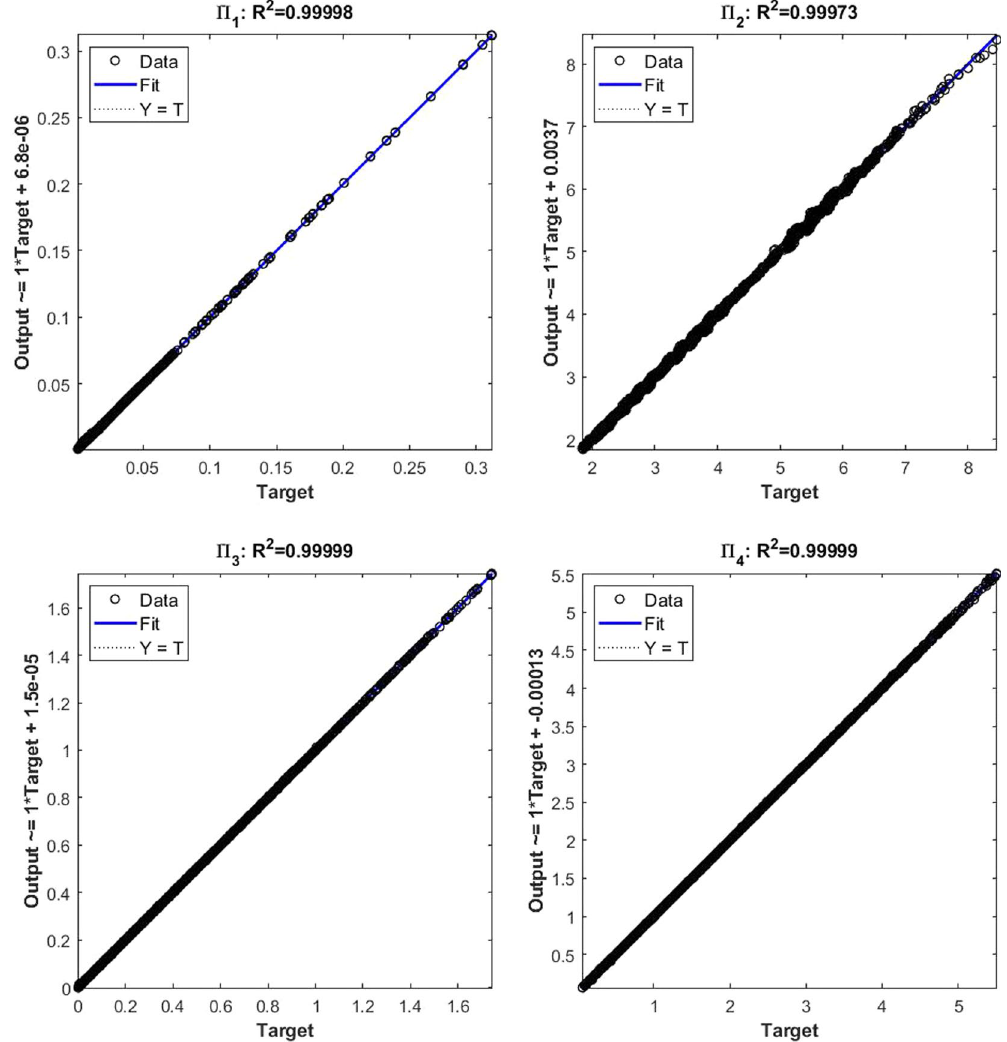
Figure 5. Correction coefficient of ANNs with 30 hidden